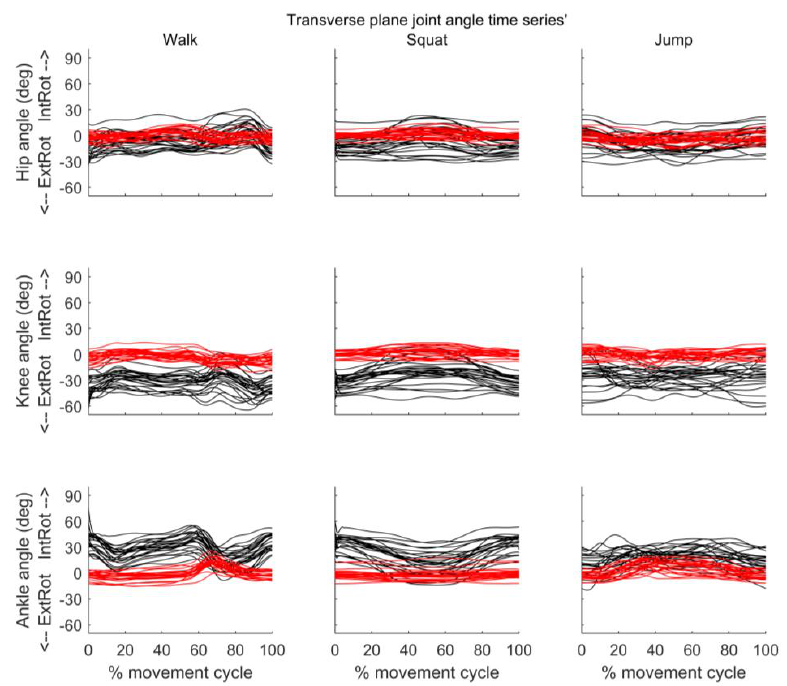
Figure 7. Transverse plane joint angles throughout the movement cycle for each participant. Time series of hip ( top row ), knee ( middle row ) and ankle ( bottom row ) joint angles obtained from VICON (black) and MVN BIOMECH (red) systems for each participant during walk ( left ), squat ( centre ), and jump ( right ). Y-axis represents joint angles in degrees and X-axis represent the movement cycle in percentage. Y-axis scale is the same as in Figures 5 and 6 to allow comparison. The difference in joint angle provided by the MVN BIOMECH and VICON systems at discrete, time points is shown in Figure 8.